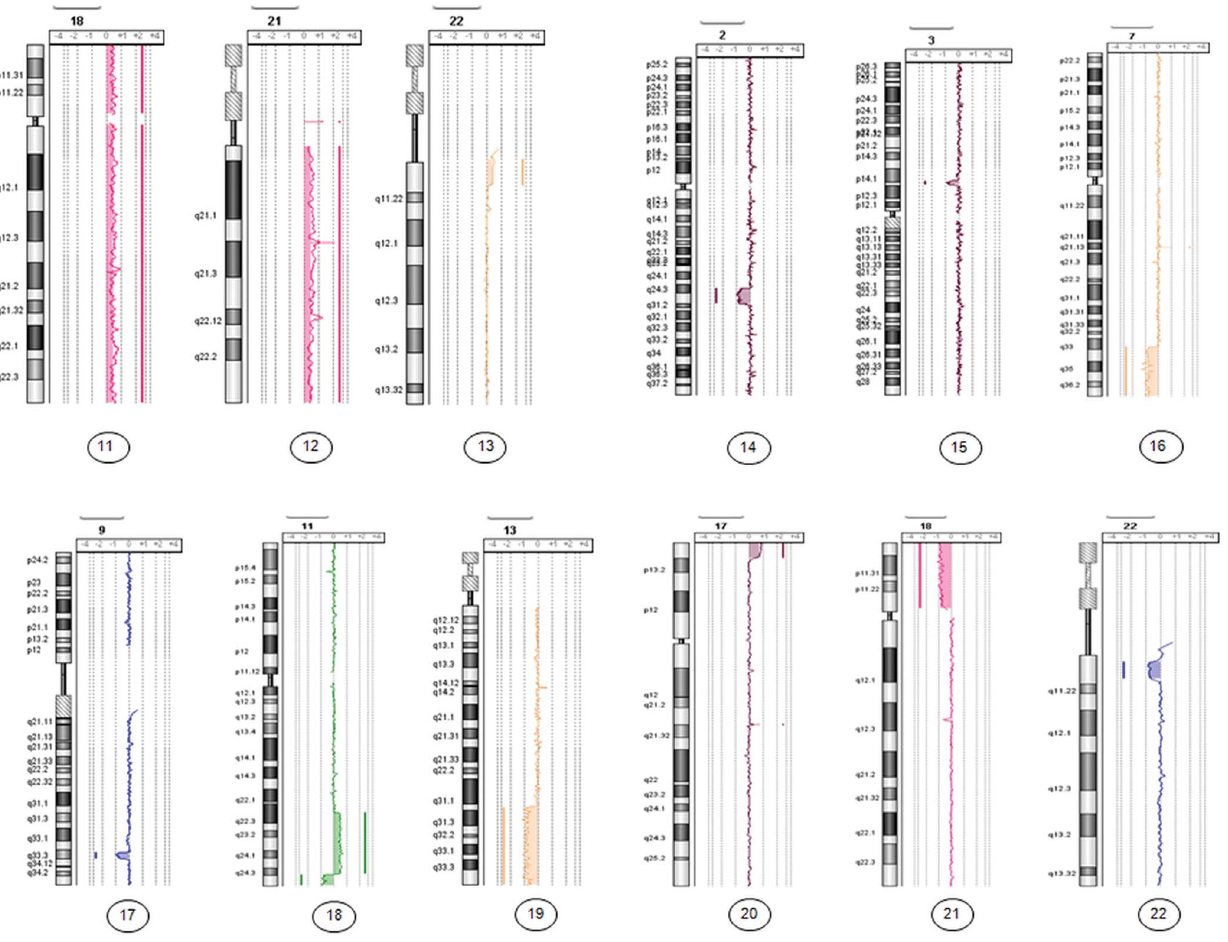
Figure 2. Genome views of 12 chromosomal abnormalities characterized by array-CGH, extracted from 1 ml of uncultured amniotic fluid from patients at more than 16 weeks of gestation. (cases 11 to 22).